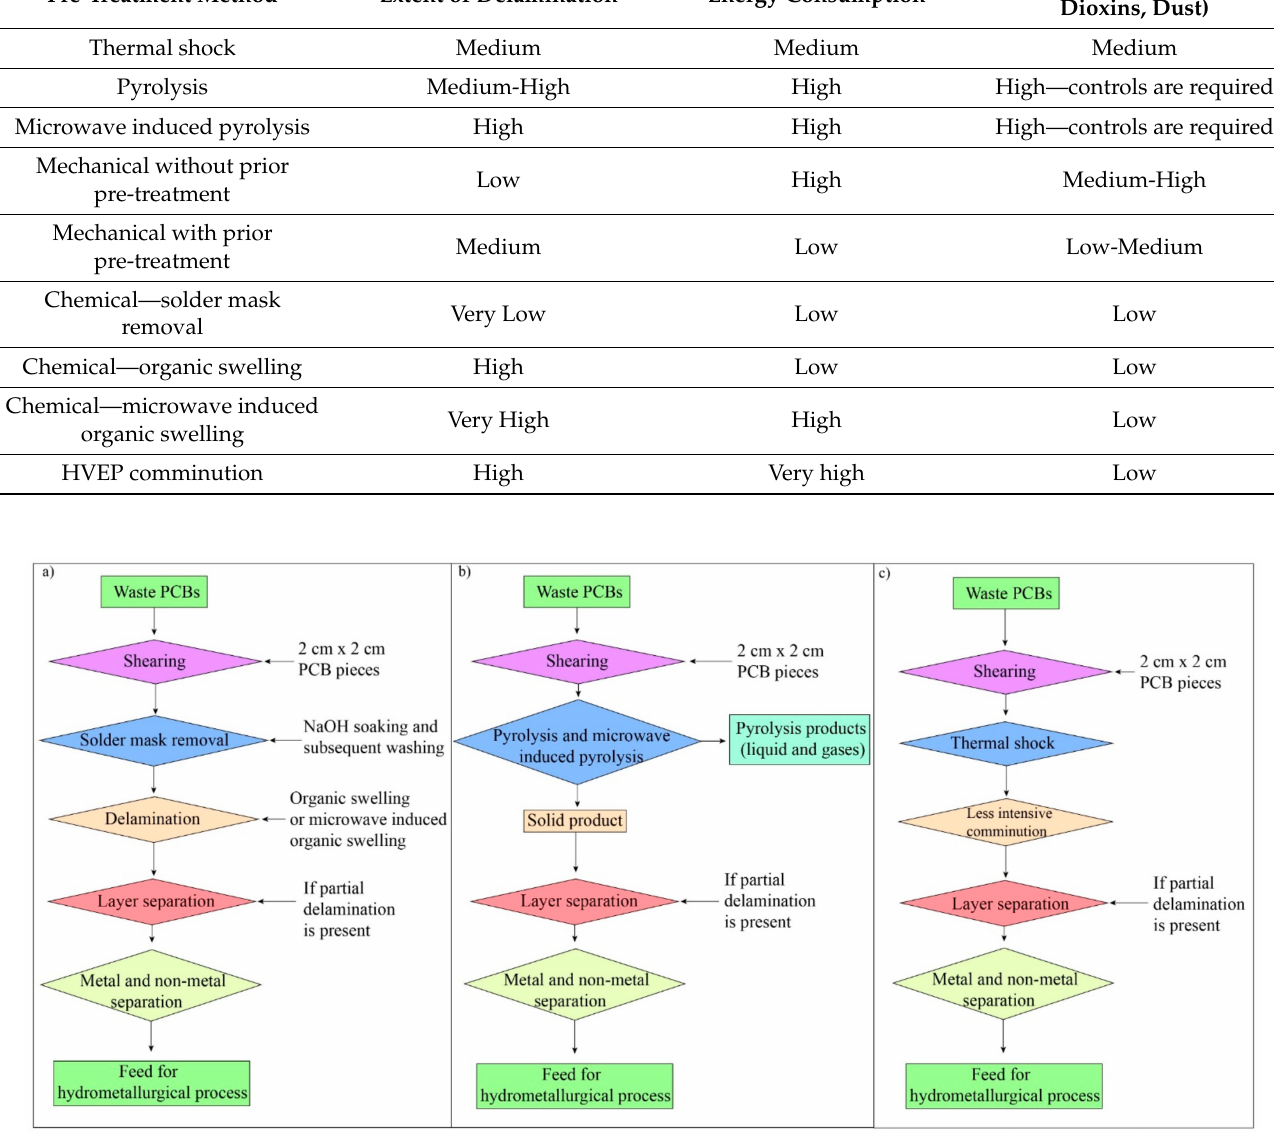
Figure 9. Proposed potential flowsheets for coarse PCB pieces: ( a ) chemical and mechanical pre-treatment ( b ) pyrolysis and mechanical pre-treatment and ( c ) thermal shock and mechanical pre-treatment